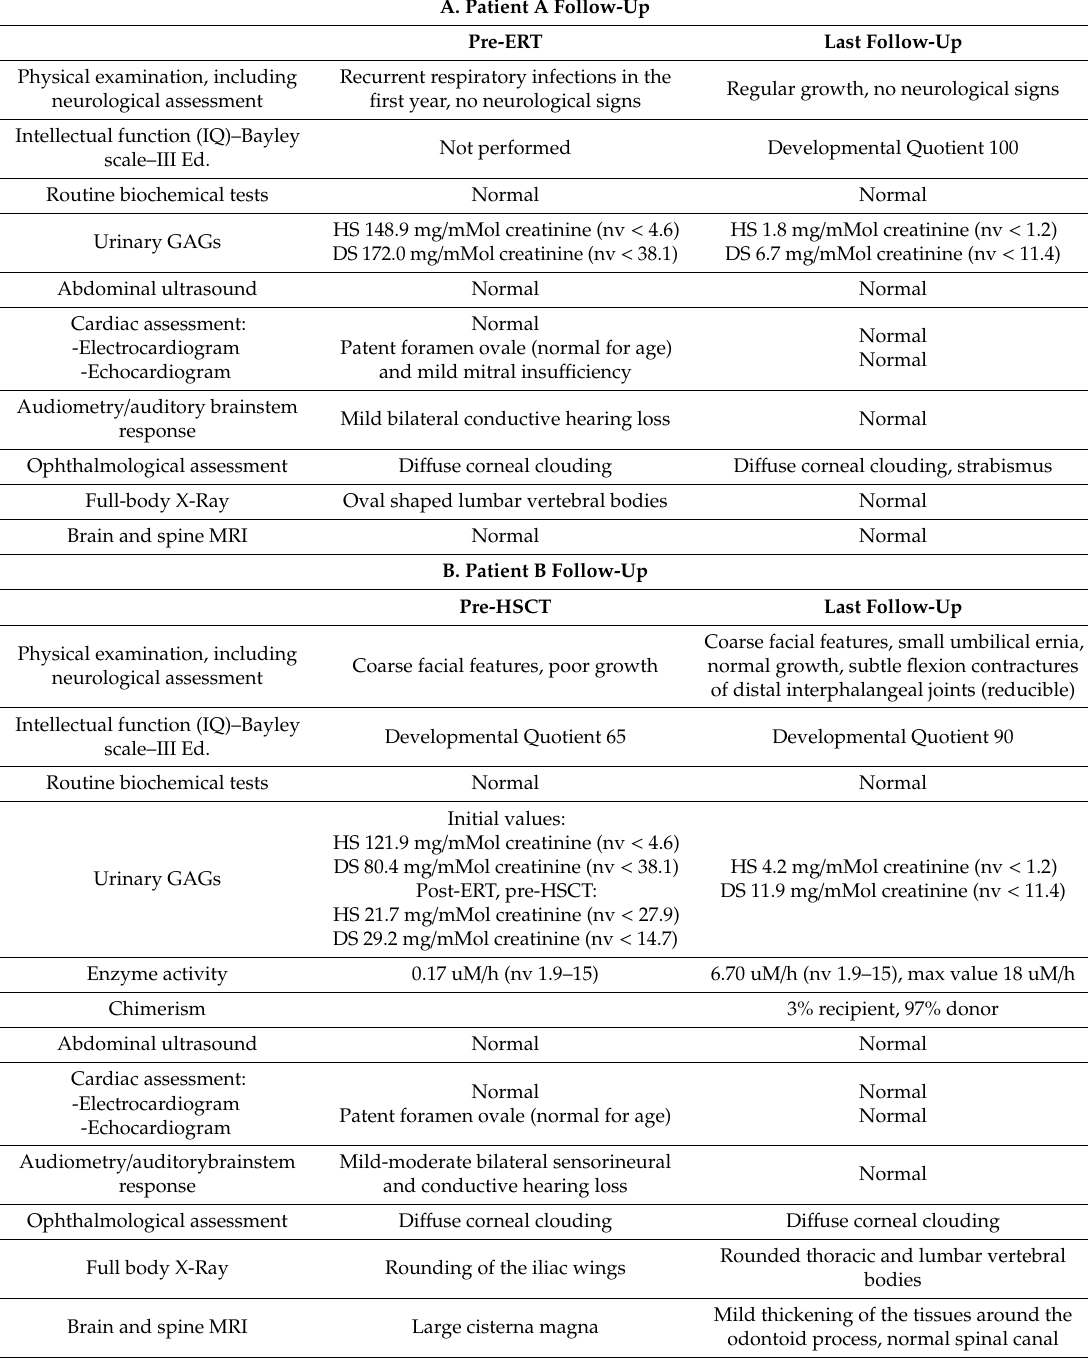
Table 4. A. Patient A follow-up; B . Patient B